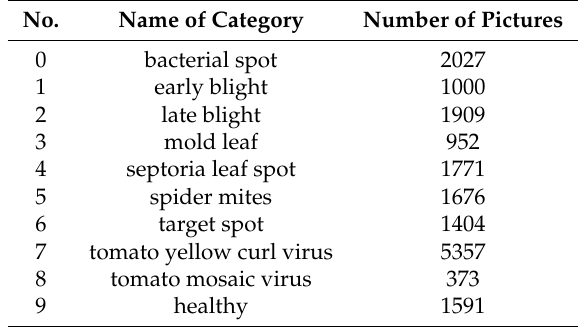
Table 1. The number of each category tomato leaf images in Plant Village dataset. No. Name of Category Number of Pictures